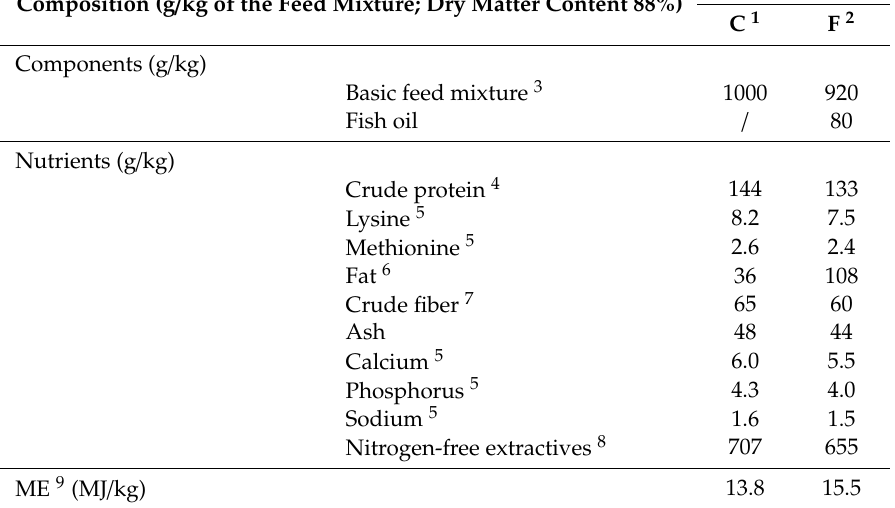
Table 1. Composition of the